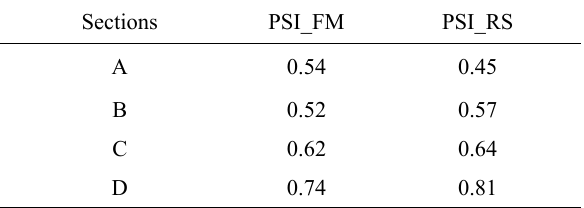
Table 2. The evaluation result of four